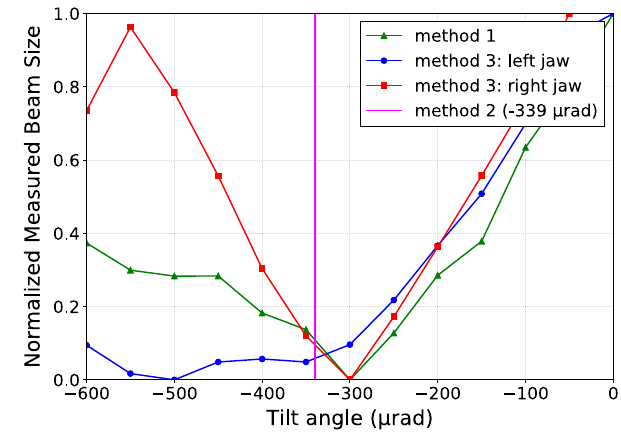
FIG. 15. Angular alignment results for the TCTPH.4R2.B2 using the three methods and the BPMs.